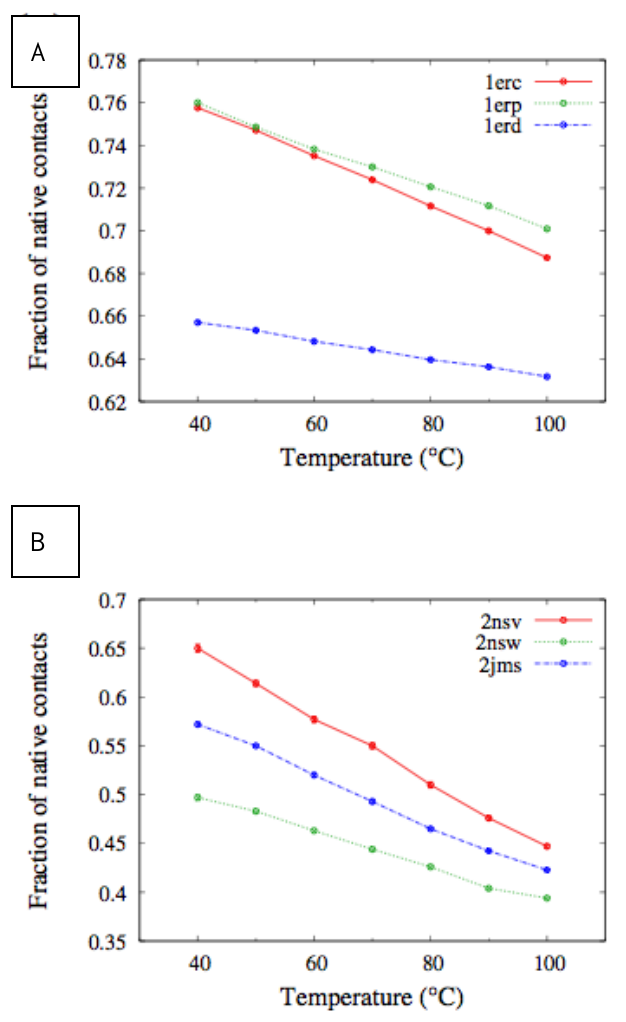
Figure 5. Temperature dependence of the fraction of native contacts for different E r ( A ) and E n ( B ) pheromones, obtained by means of MC simulations in the CG model defined in the Experimental